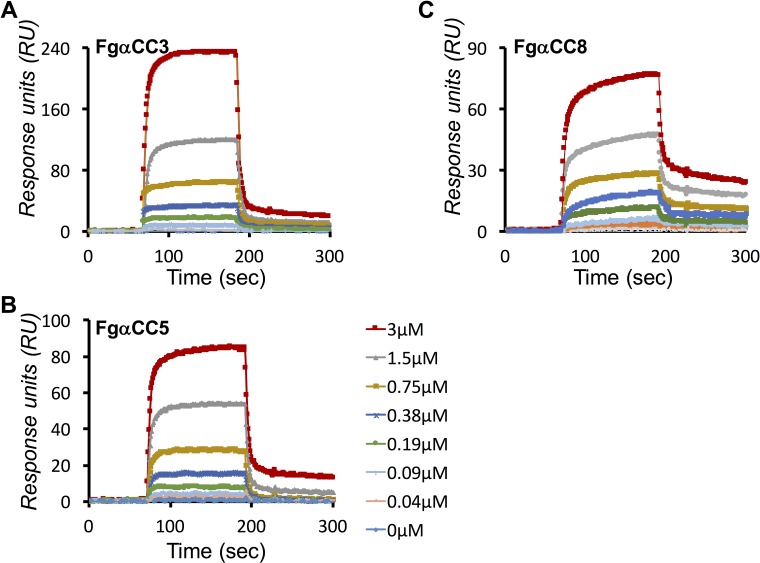
Characterization of binding kinetics of LigB12-FgαCC interactions.SPR analysis of LigB12-FgαCC interactions was conducted by flowing (A) FgαCC3 (B) FgαCC5 and (C) FgαCC8 at 0, 0.047, 0.094, 0.188, 0.375, 0.75, 1.5 and 3 μM through LigB12-immobilized CM5 sensor chip. The measured kon, koff, and KD values for LigB12-FgαCC3 interaction are 4.81 × 104 ± 0.15 M-1 s-1, 3.39 × 10−2 ± 0.22 s-1, 0.704 ± 0.14 μM, respectively. The kinetic parameters of LigB12-FgαCC5 interaction were measured as 3.69 × 104 ± 0.67 M-1 s-1, 3.84 × 10−2 ± 0.14 s-1, 1.040 ± 0.21 μM. For LigB12-FgαCC8 interaction, the parameters of binding kinetics were measured as kon, 3.72 × 104 ± 0.16 M-1 s-1, koff, 3.57 × 10−2 ± 0.08 s-1, KD, 0.959 ± 0.05 μM.